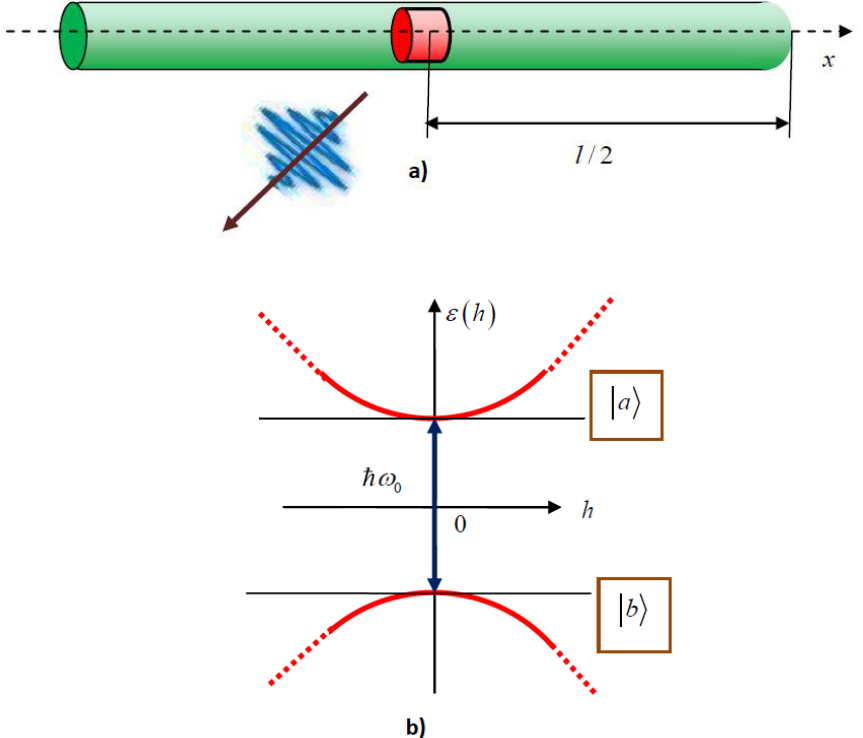
Figure 1. General illustration of the system used as a model of quantum antenna in the strong coupling regime. ( a ) The antenna configuration. The semiconductor InAsP quantum dot (red colored) positioned inside the semiconductor InP quantum wire (green colored). The quantum dot is coupled with quantum wire via quantum tunneling through the potential barriers. ( b ) The energy spectrum of the shown system in the case of EM field absence. It consists of two zones, valence and conduction, which are separated by the energy gap. The dominant support to the energy of quantum transitions is given by the small region near the band minimum at the zone center and is approximately equal to (cid:125) ω 0 .